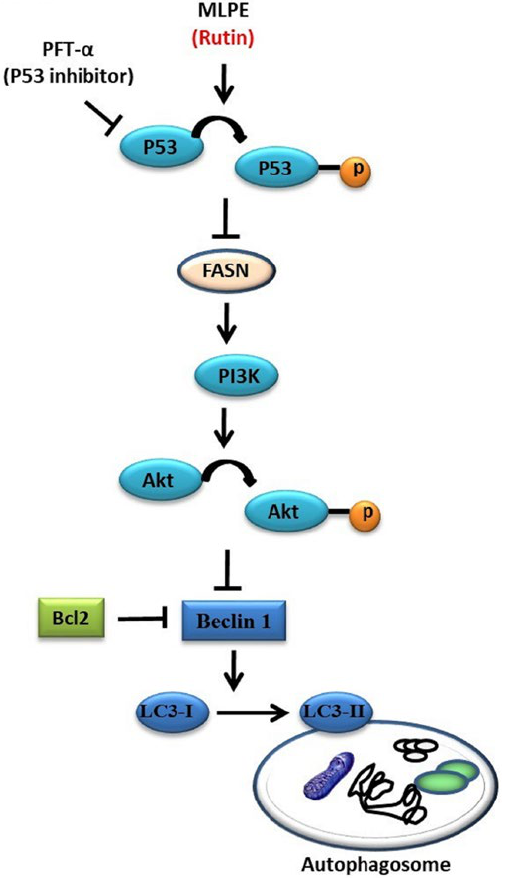
Figure 5. Schematic diagram illustrating the p53-dependent autophagy of HepG2 cell treated with MLPE or rutin.